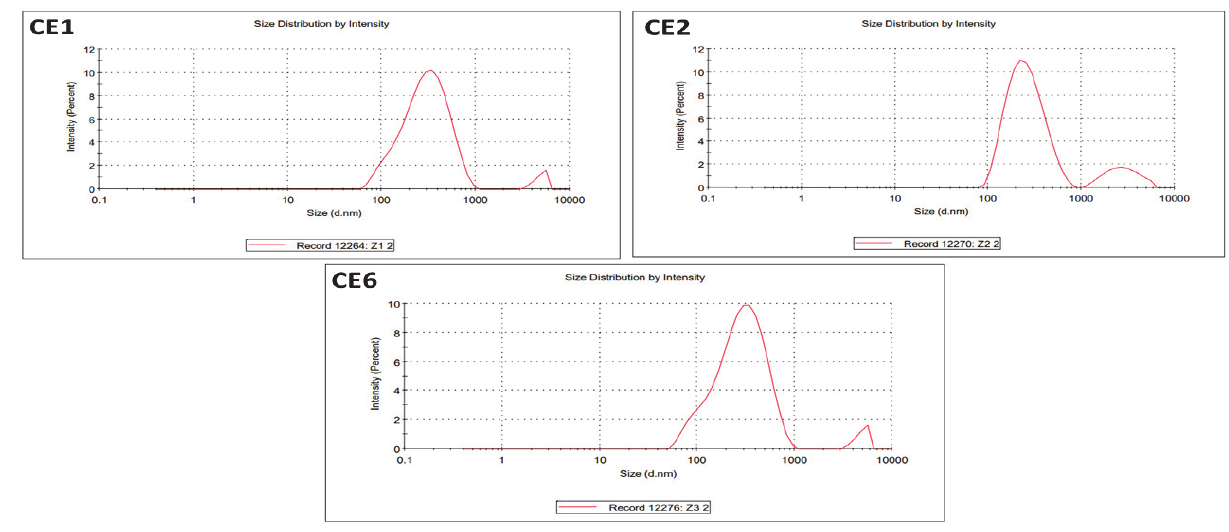
Molecules 2022 , 27 , x FOR PEER REVIEW Figure 5. DLS graphs of CE1, CE2, and CE6. Figure 5. DLS graphs of CE1, CE2, and CE6.